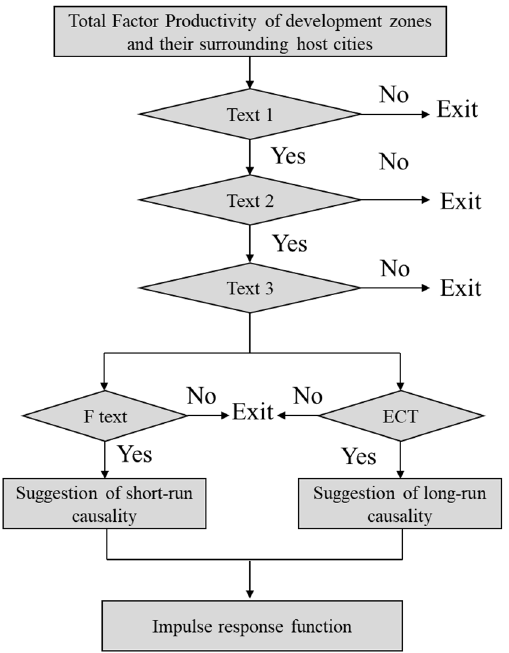
Figure 2. Research design of the causality test. Text 1 is the panel unit root test, text 2 is the panel cointegration test, and text 3 is the panel Granger causality